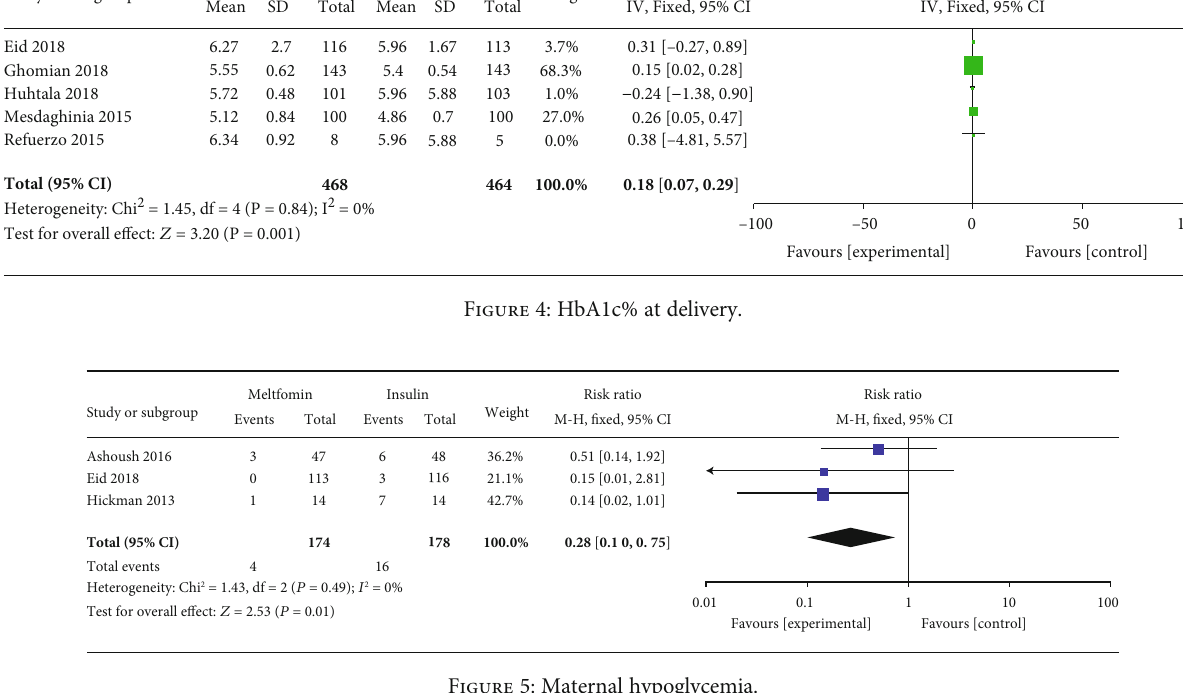
Figure 5: Maternal hypoglycemia.